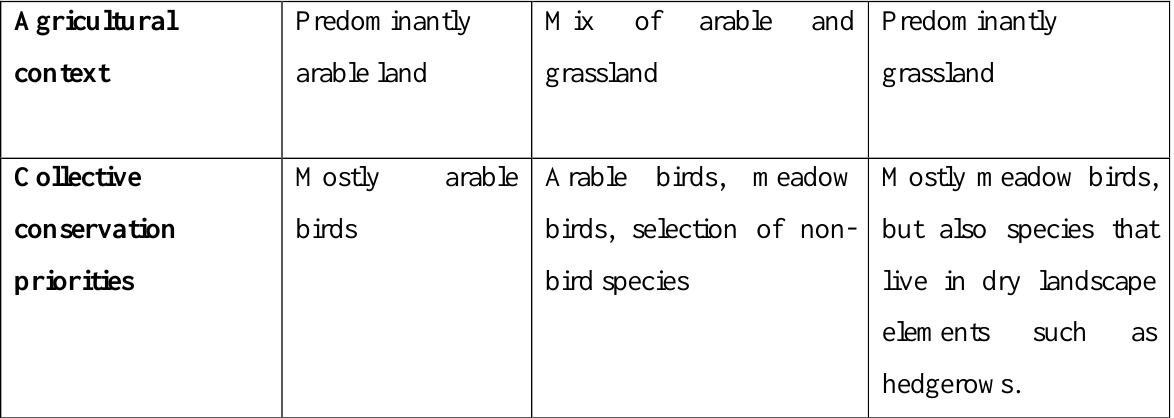
Table 1: Main characteristics of the case